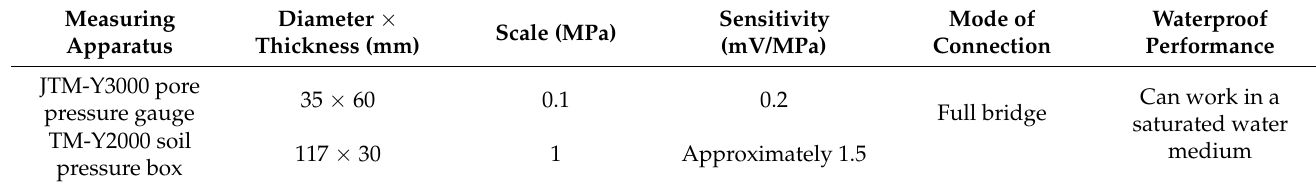
Table 3. Main technical parameters of the field measuring